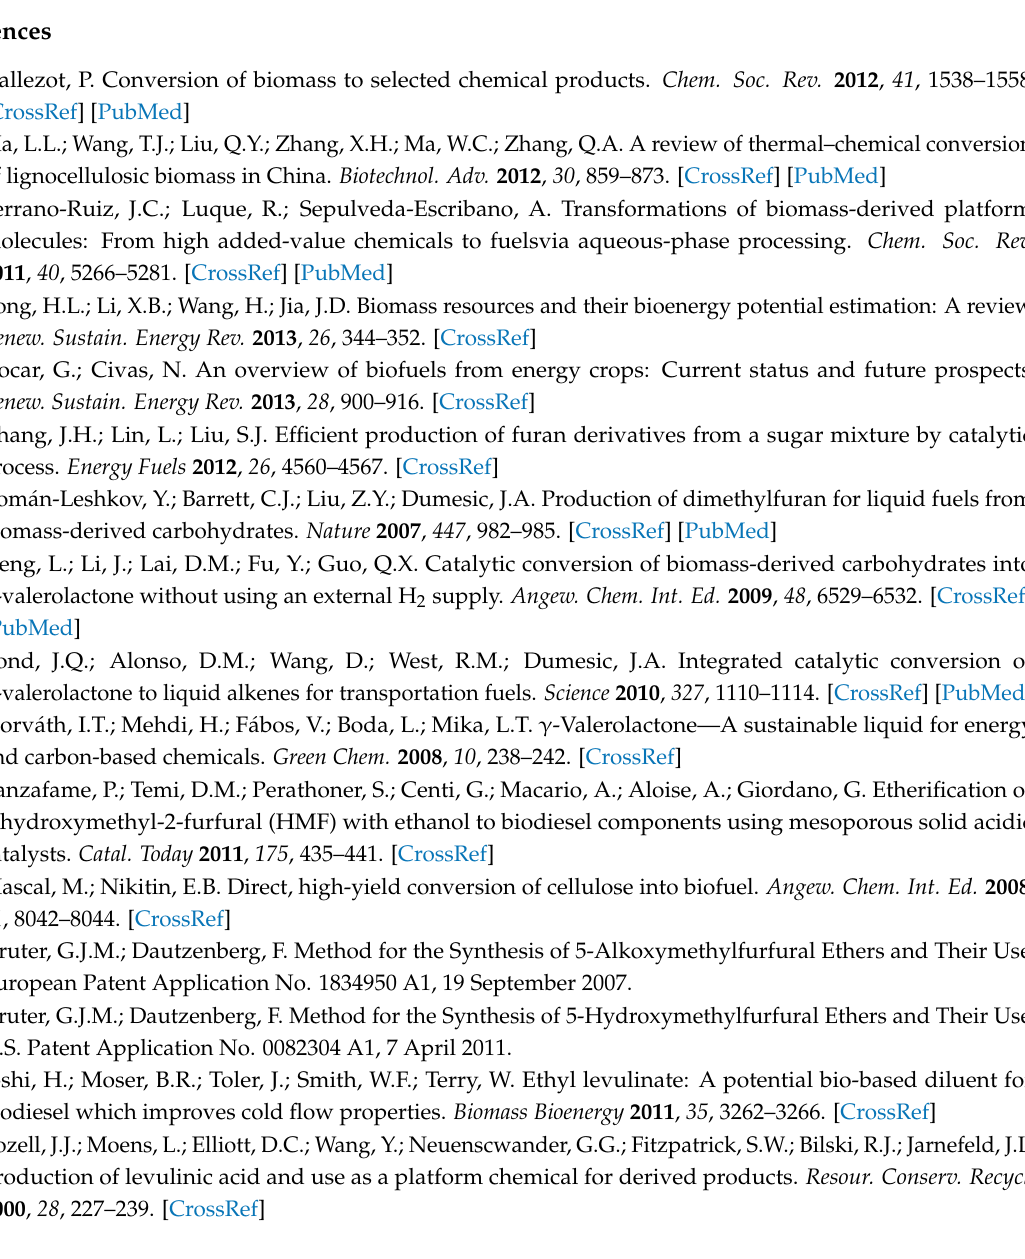
Figure S1: (a) The XRD of Cu-BTC and (b) the Cu and porous carbon composites derived from Cu-BTC carbonization. Figure S2: (a) Nitrogen adsorption-desorption isotherm and (b) the corresponding pore size distribution of the C-SO 3 H. Figure S3: The general GC-MS image of the reaction products, the inset images are the MS of EL and EMF respectively. Figure S4: (a) The X-ray diffraction pattern, (b) the S2p XPS spectra and (c) the FT-IR spectra of catalysts in first and second catalysis at the condition of 140 ◦ C for 8 h. Author Contributions: Z.W. and Q.C. conceived and designed the experiments. Z.W. prerformed the experimental work, analyzed the data and wrote the